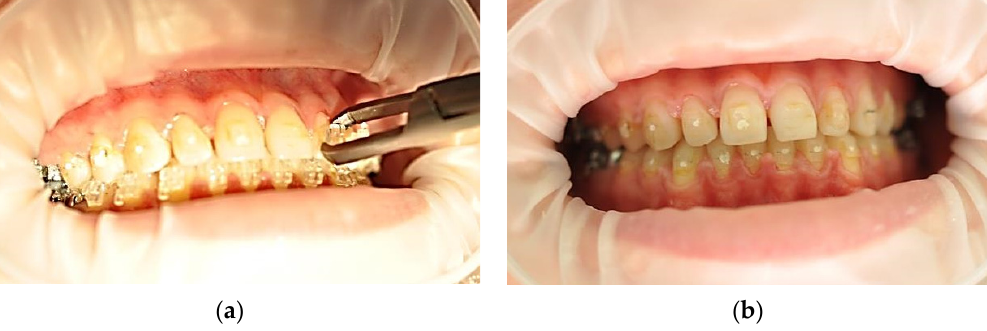
Figure 7. Use of the conventional method to dental units 2.1–2.3 ( a ) and clinical aspect after debonding ( b ).